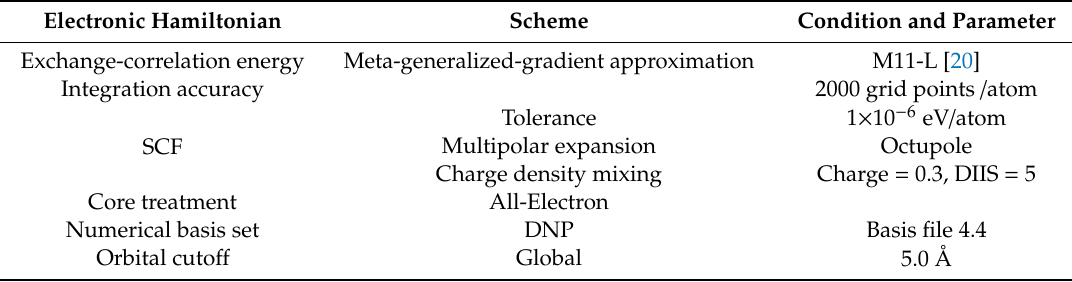
Table 1. Schemes and parameters adopted in the first-principles calculations by